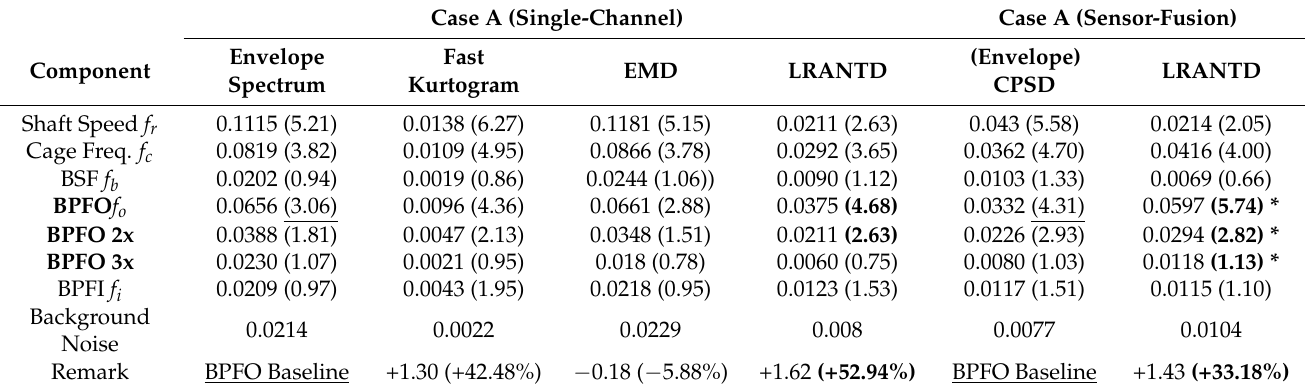
Table 3. Characteristic spectral amplitude in g (with its ratio to the mean background noise) for Case A.